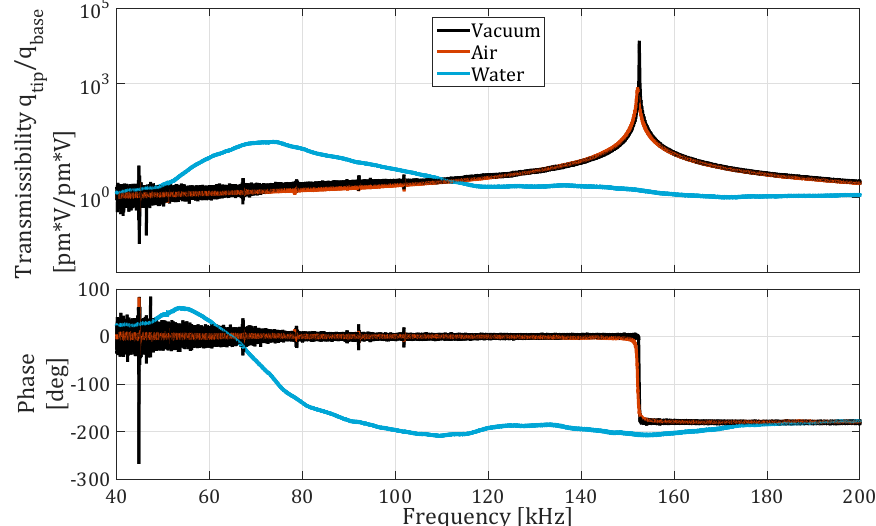
Figure 7. Frequency response of the NCLR cantilever, measured in in water, air, and vacuum (0.6mbar).